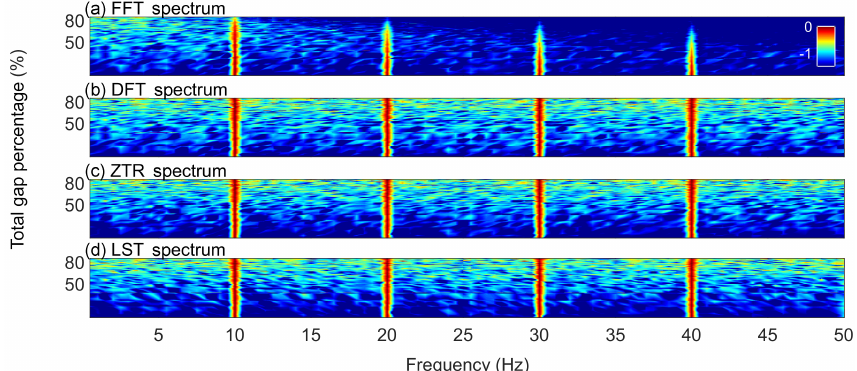
Figure 9. MSG test applied to the synthetic data: amplitude spectra in color code as a function of TGP and frequency for: FFT (panel a ) DFT (panel b ), ZTR (panel c ) and LST (panel d ). Color as in Fig. 4.